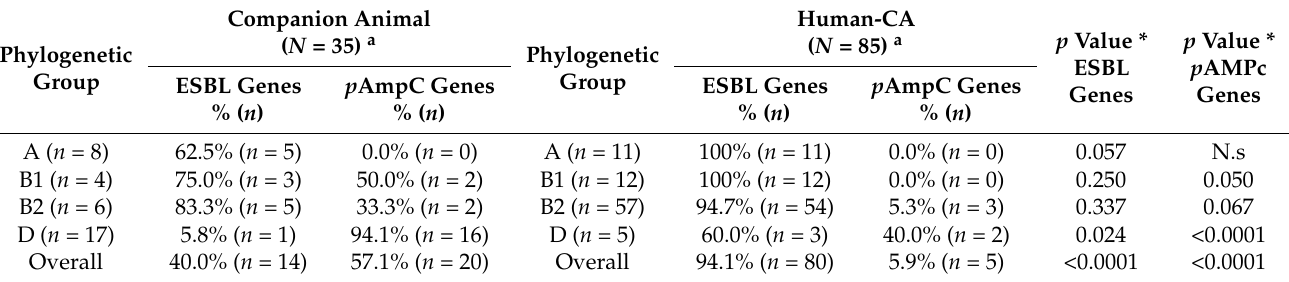
Table 3. ESBL and p AmpC-producing E. coli by phylogenetic group.